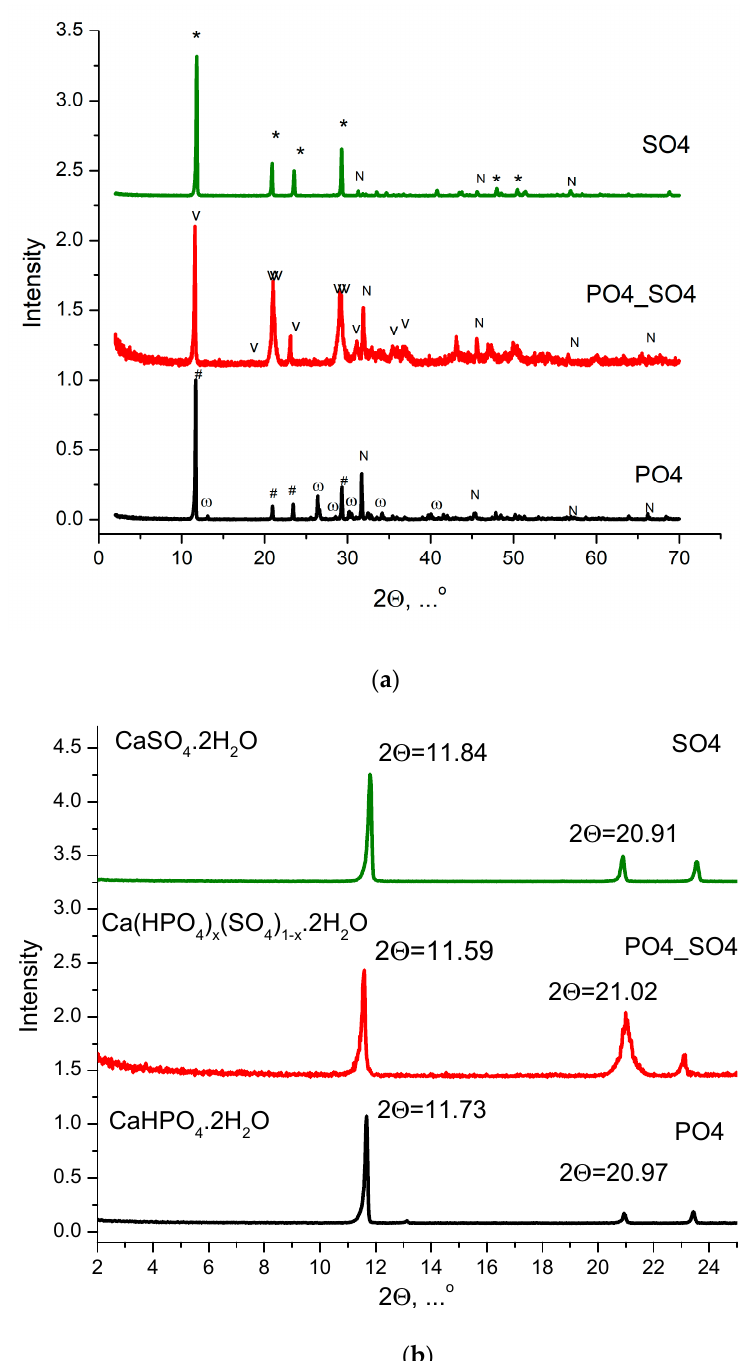
Figure 1. XRD for 2 Θ in interval of 2–70° ( a ) and fragment of XRD for 2 Θ in interval of 2–25° ( b ) of powders synthesized from aqueous solution of CaCl 2 and Na 2 SO 4 (in green); from CaCl 2 and mixed-anionic solution of Na 2 HPO 4 /Na 2 SO 4 (in red); from CaCl 2 and Na 2 HPO 4 , (in black): *—CaSO 4 ·2H 2 O (card PDF 21-816); N—NaCl (card PDF 5-628); v—Ca(HPO 4 ) х (SO 4 ) 1 −х ·2H 2 O (card PDF 46-657); Ca(HPO 4 ) 0.5 (SO 4 ) 0.5 ·2H 2 O (card Match 96-900-0654); #—CaHPO 4 ·2H 2 O (card PDF 9-77); ω —CaHPO 4 (card PDF 9-80).